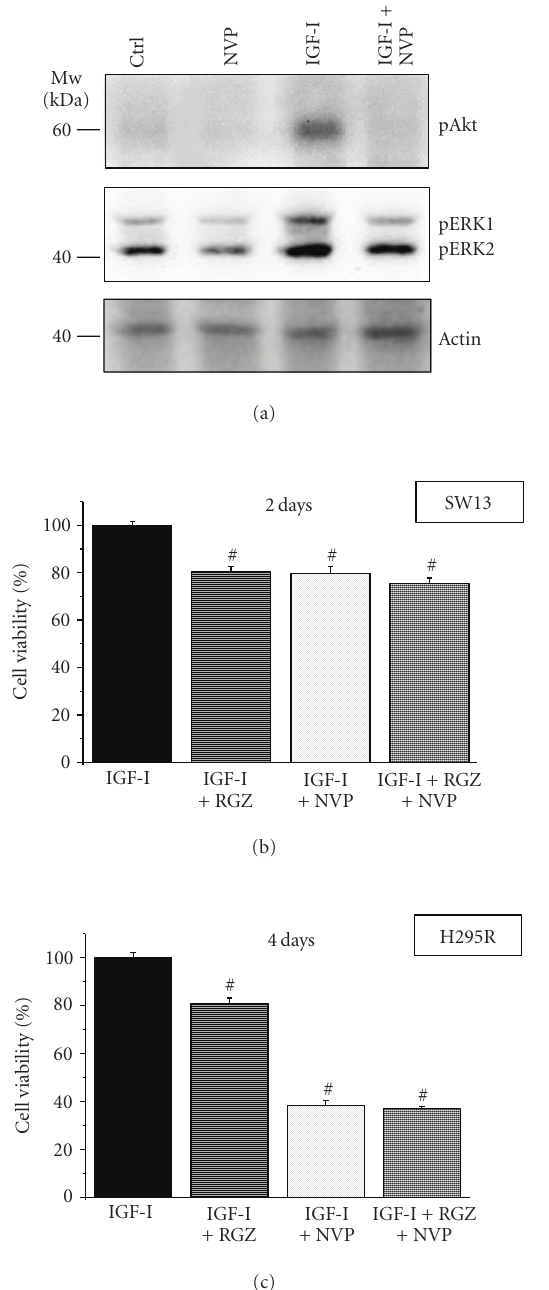
Figure 7: ERK and Akt activation downstream of the IGF-IR mediates IGF-I stimulation of cell proliferation . Western blot analysis of H295R cell lysates following 15-minute stimulation with 10nM IGF-I in the presence or absence of 1 μ M NVP-AEW541 (NVP) inhibitor of the tyrosine kinase activity of IGF-IR (a). The inhibitor blocks phosphorylation of Akt (upper panel) and of ERK1/2 (middle panel) both in basal conditions and following IGF-I stimulation. Lane protein normalization for actin is shown in the lower panel. Molecular weight markers are indicated. Cell proliferation was evaluated by MTS assay following 2 or 4 day stimulation with the indicated treatments (10nM IGF-I, 20 μ M RGZ, 1 μ M NVP) in SW13 (b) or H295R (c) cells, respectively. Mean ± SE percentage of OD over respective control IGF-I taken as 100%. # P < . 001 versus IGF-I, n = 6.